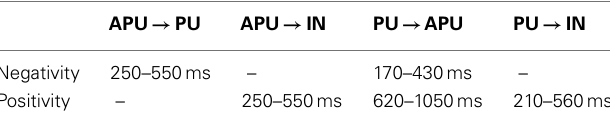
Table 7 | Significant effects (presented as time windows) for types of stress